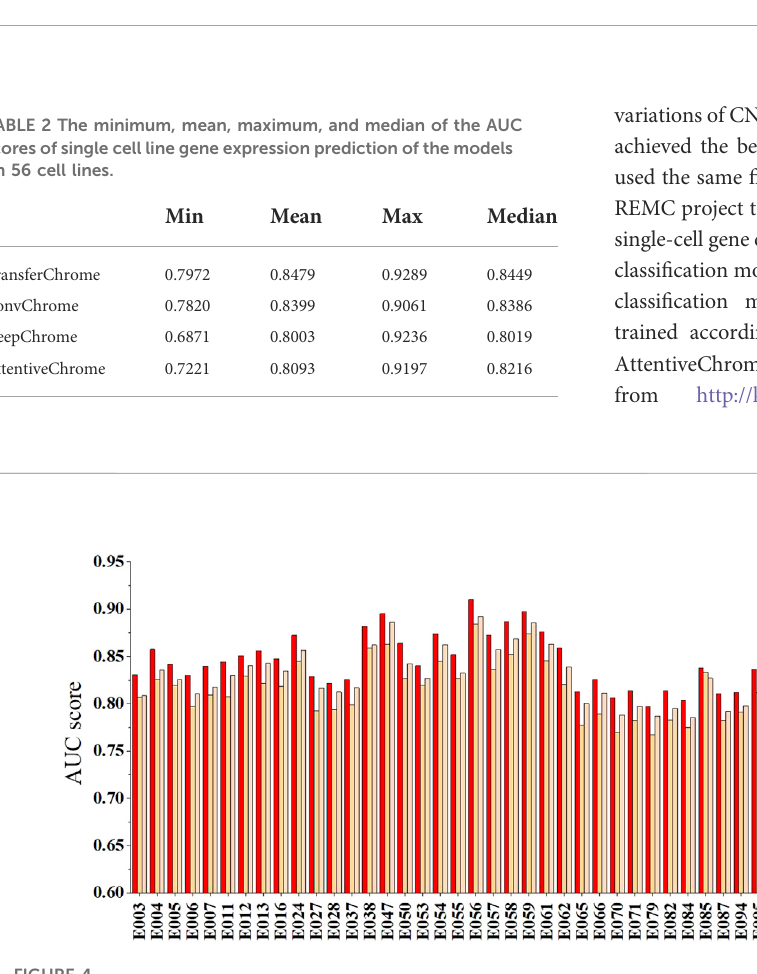
FIGURE 3 Single cell line gene expression prediction performance comparison on 56 cell lines of the models.